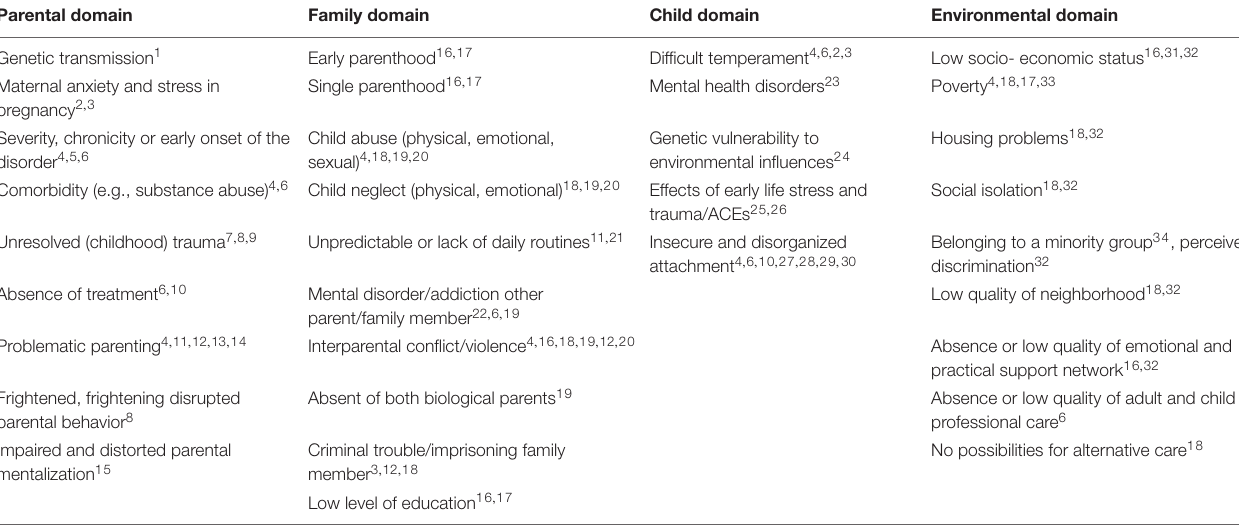
TABLE 1 | Risk factors during pregnancy and early childhood in different domains related to parental mental